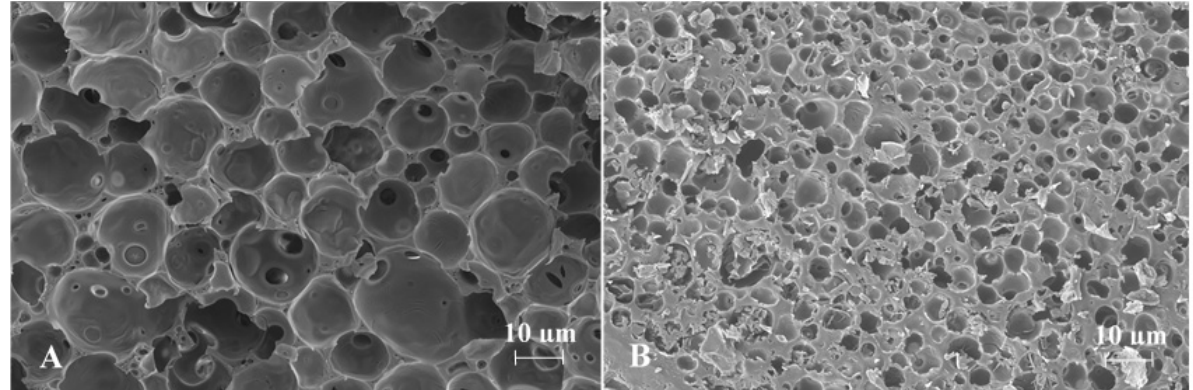
Figure 4. Scanning electron microscopy cross-section image of the sponge-like structure at the inner part of spherical in situ